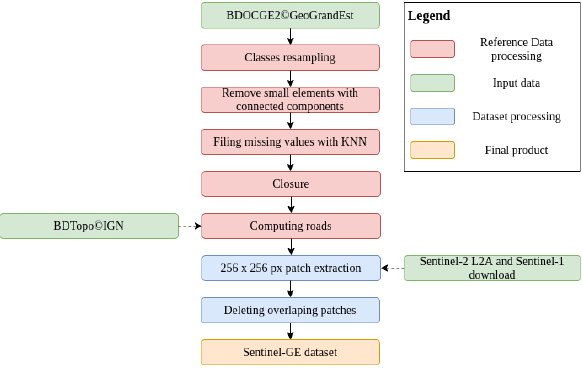
Figure 2. Methodology for MultiSenGE